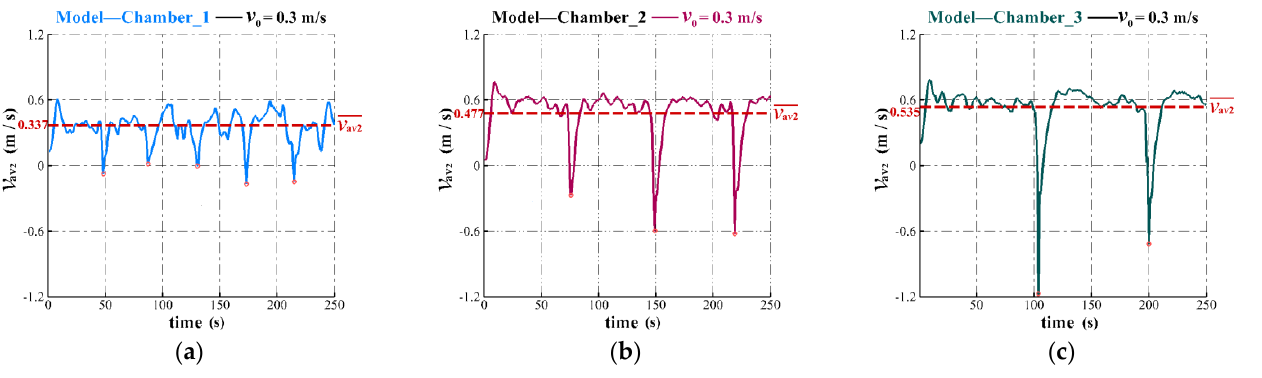
Figure 11. Distribution of the velocity in the outlet of the deflector plate for different air chamber volumes of ( a ) 0.455, ( b ) 0.797, and ( c ) 1.067 m 3 . The pink circles represent the minimum velocities, and the red dashed lines indicate time-averaged velocities of the deflector plate outlet. Table 5. Computational results of the oxygenation performance with different volumes of the air chamber.